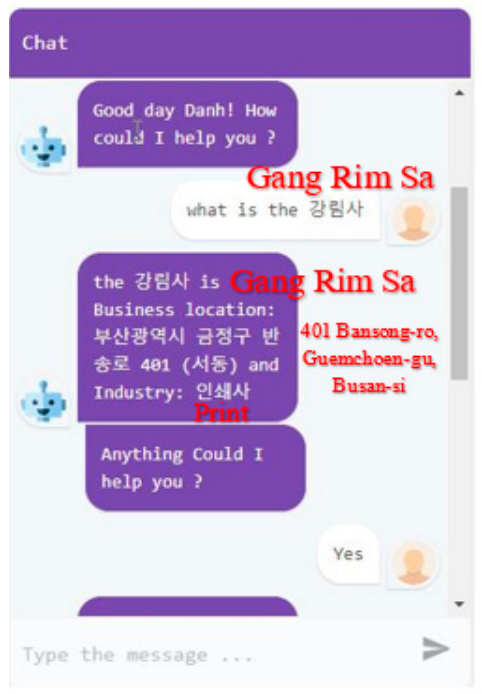
Figure 28. Assistant Systems providing information about other companies in Korea.